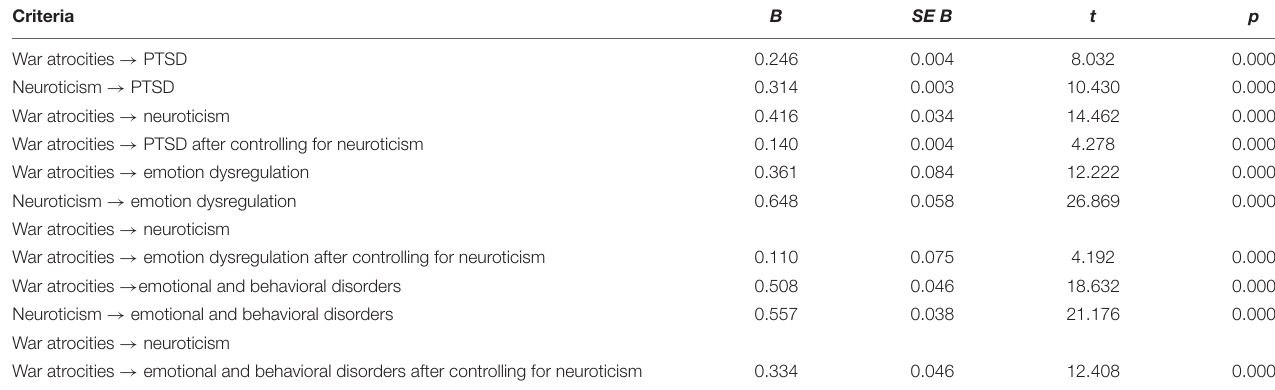
TABLE 2 | Predictor and the outcome variables before and after controlling for the effects of the mediator variable neuroticism. Criteria B SE B t p War atrocities → PTSD